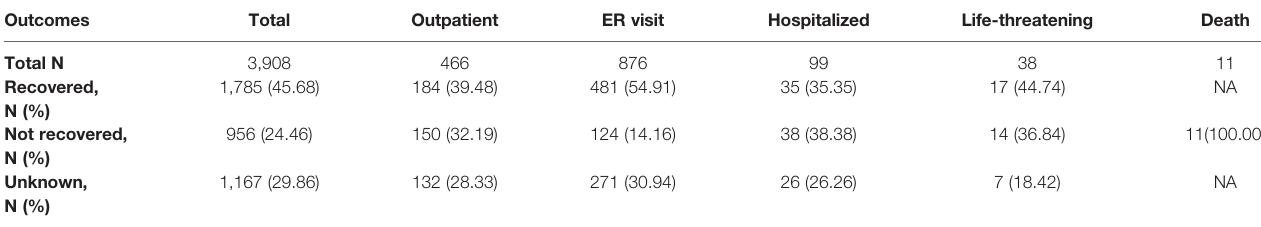
TABLE 3 | Outcomes of patients with AEs after COVID-19 vaccine sourced from the VAERS database in December 2020 (updated to December 30, 2020).